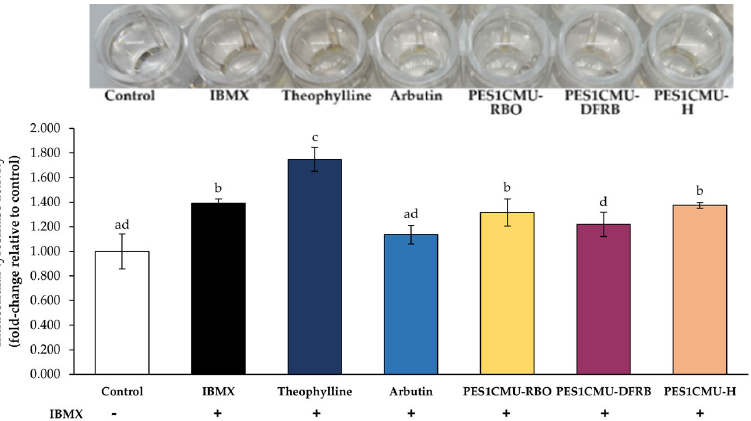
Figure 3. Effects of rice bran oil (PES1CMU − RBO), defatted rice bran extract (PES1CMU − DFRB), and husk extract (PES1CMU − H) of Oryza sativa L. cv. PES1CMU extracts on intracellular tyrosinase